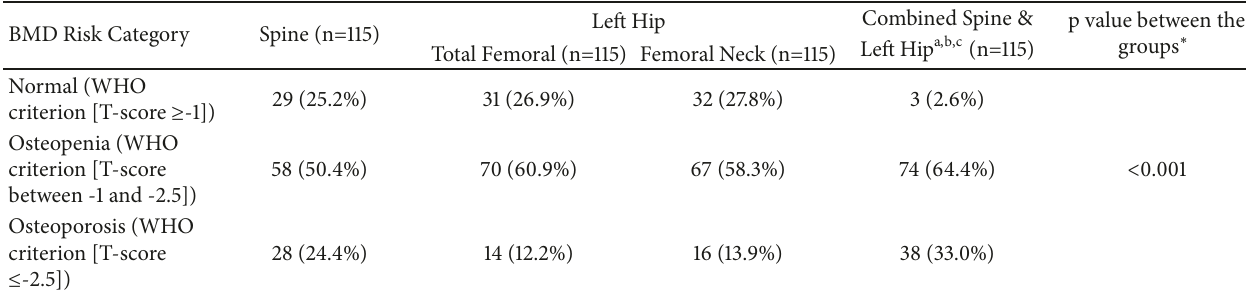
Table 2: BMD measures at spine, total hip, and femoral neck.